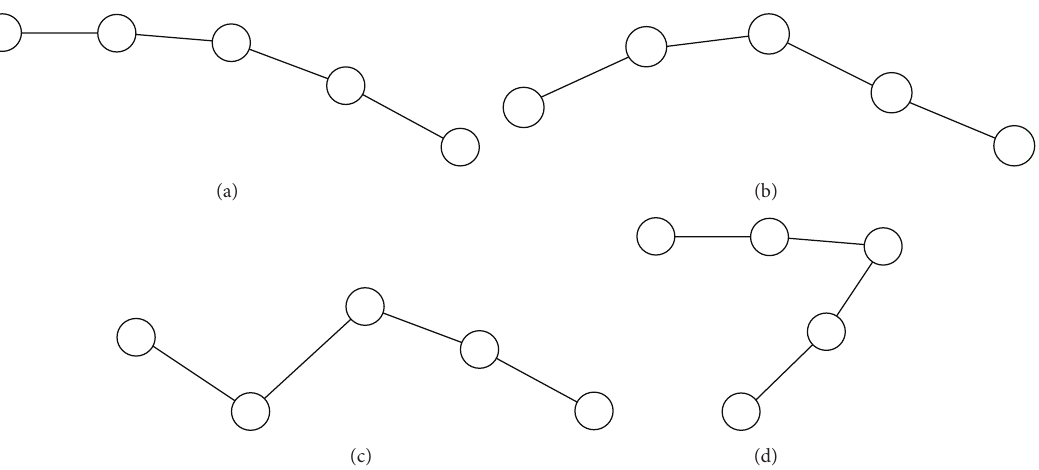
Figure 11: Sensor arrays are often improperly deployed with patterns that are not the linear array formation.